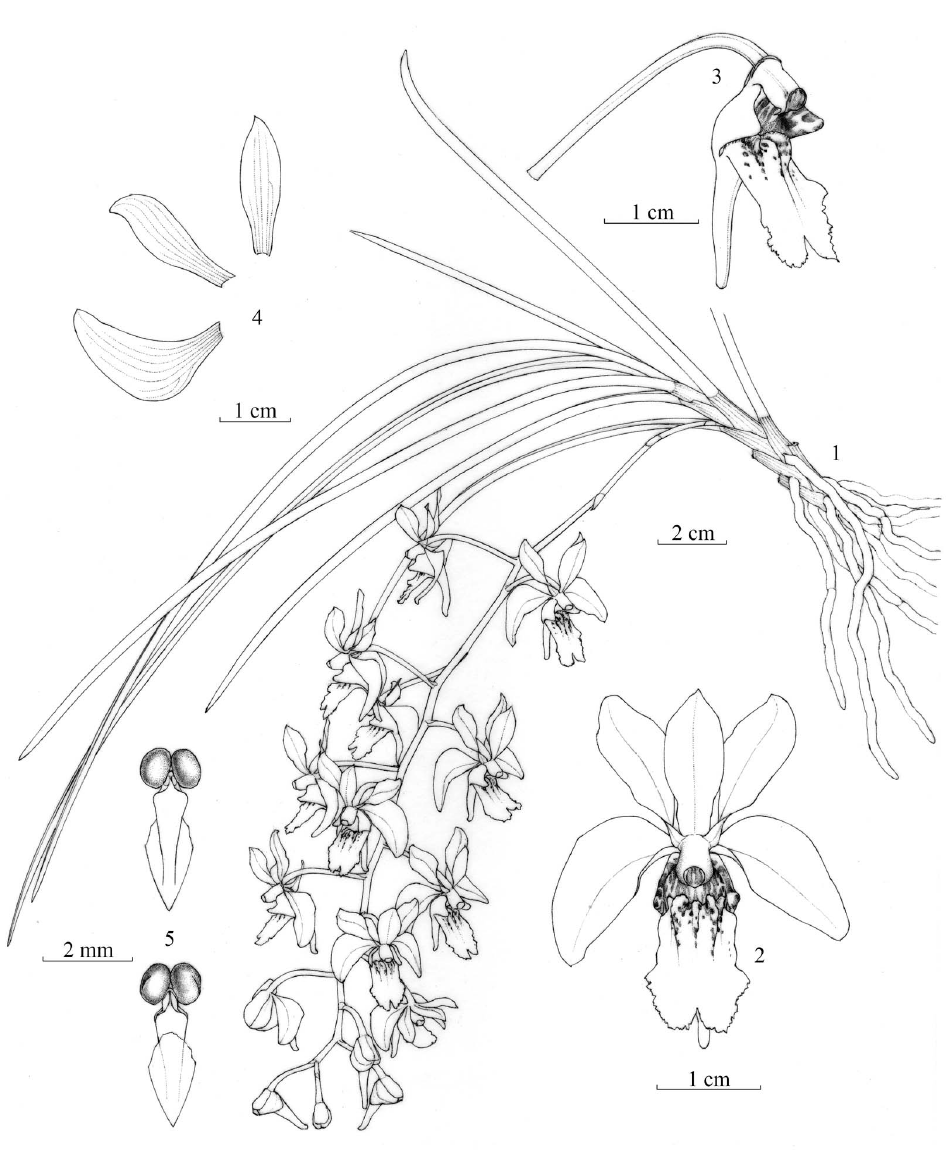
Figure 3. Holcoglossumsingchianum G. Q. Zhang, L. J. Chen et Z. J. Liu. 1. Flowering plant; 2. Flower, front view; 3. Lip and column, side view; 4. Dorsal sepal, petal, and lateral sepal; 5. Pollinarium, front view and back